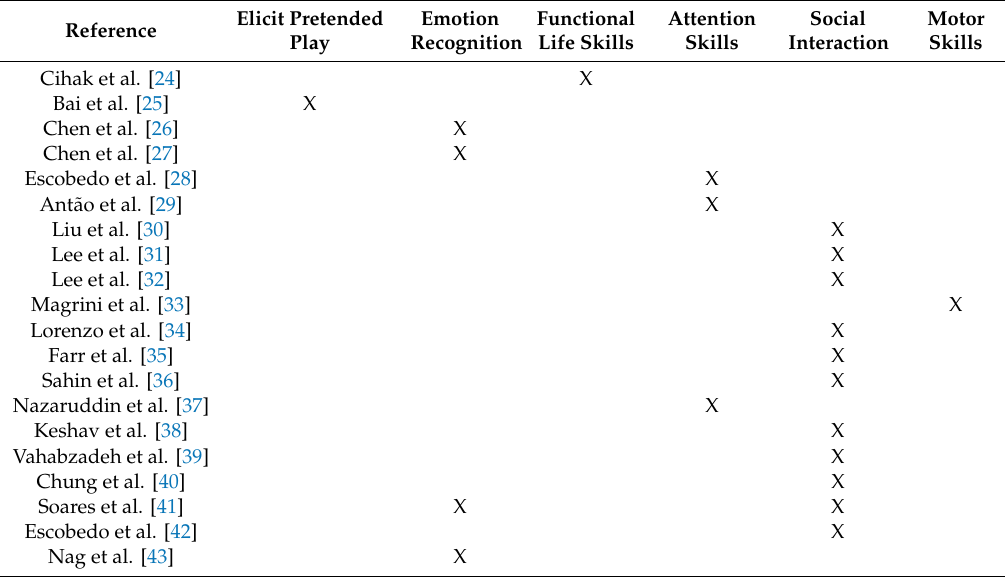
Table 2. Dependent variables for included studies.